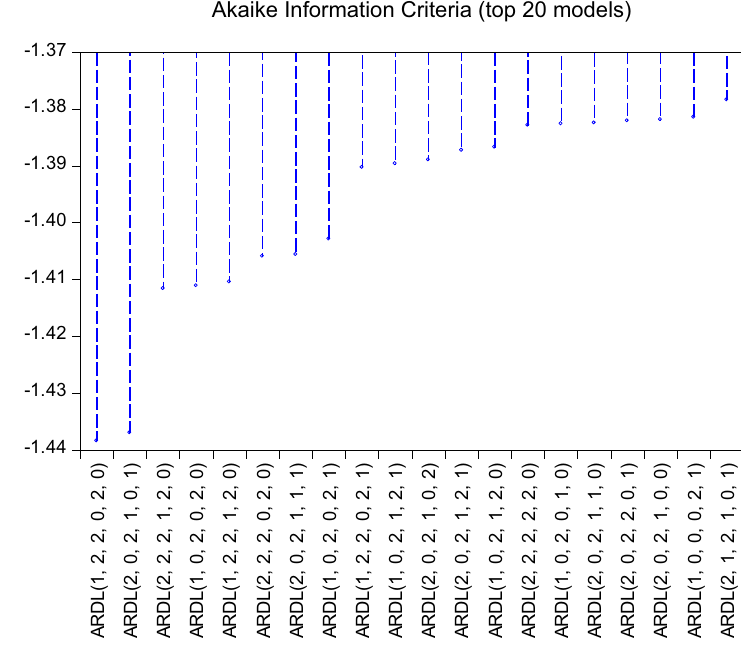
Figure A4. Akaike information criteria ’